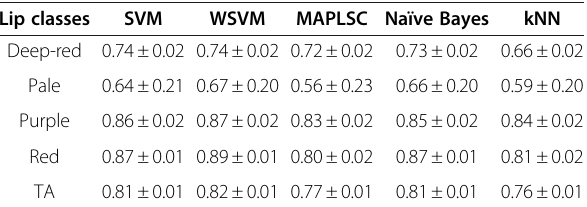
Table 3 Accuracy of lip image classification using SVM, WSVM, kNN, MAPLSC and Naïve Bayes on the features selected by mRMR (mean±variance)